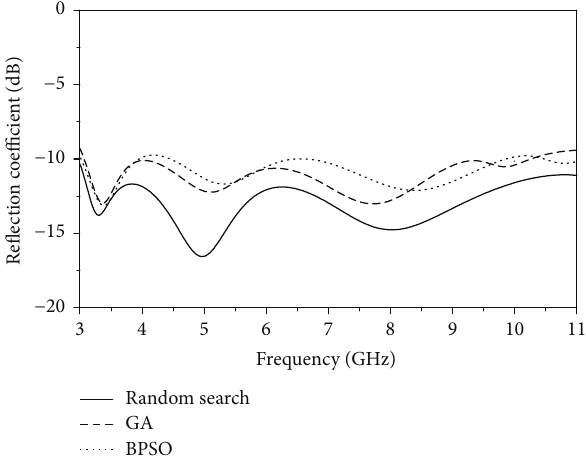
Figure 5: Simulated reflection coefficients of the optimized dual- band monopole antennas corresponding to the GA, the BPSO, and the random search algorithm.